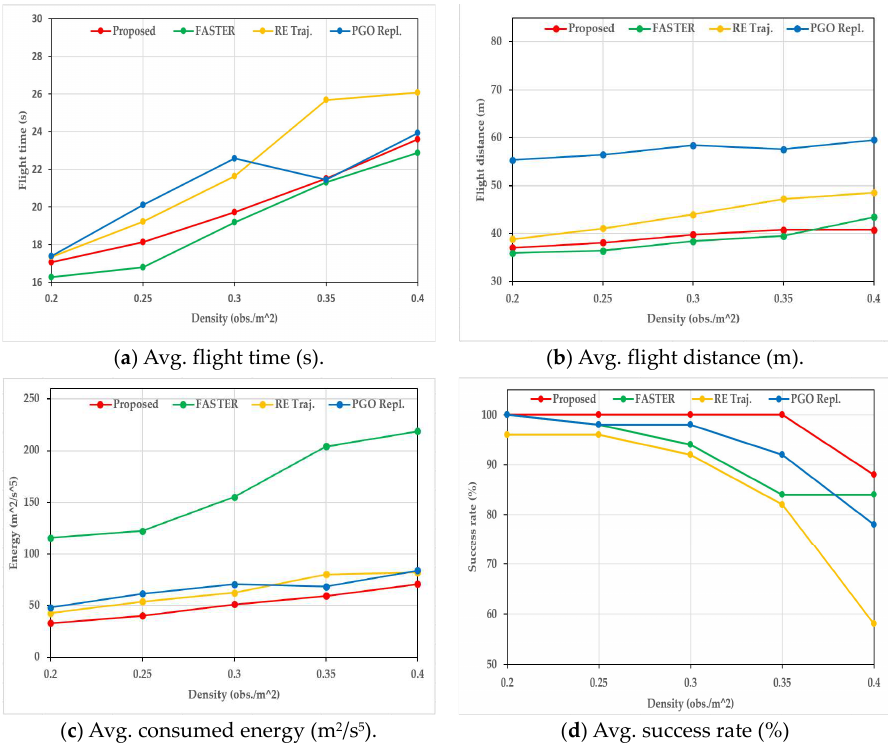
Figure 9. Results of the comparisons between the proposed method and FASTER, RET, PGO in different obstacle densities.